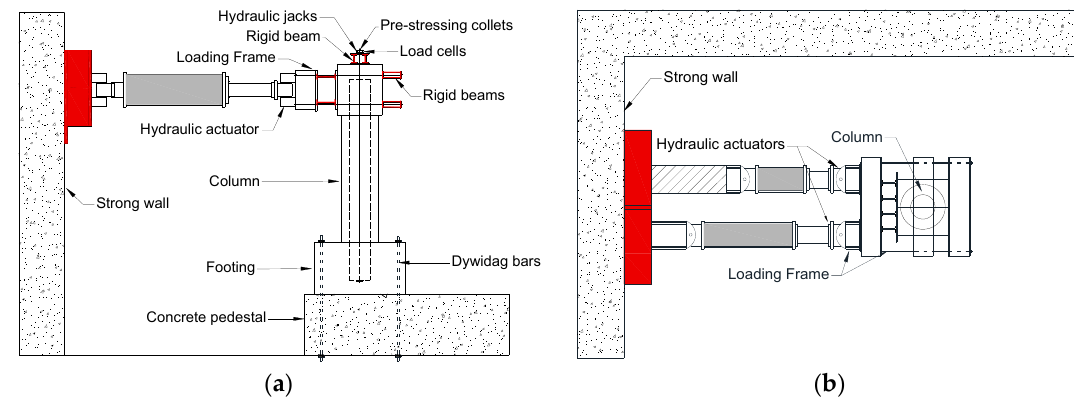
Figure 2. Experimental Test Setup ( a ) Elevation, ( b ) Top view.